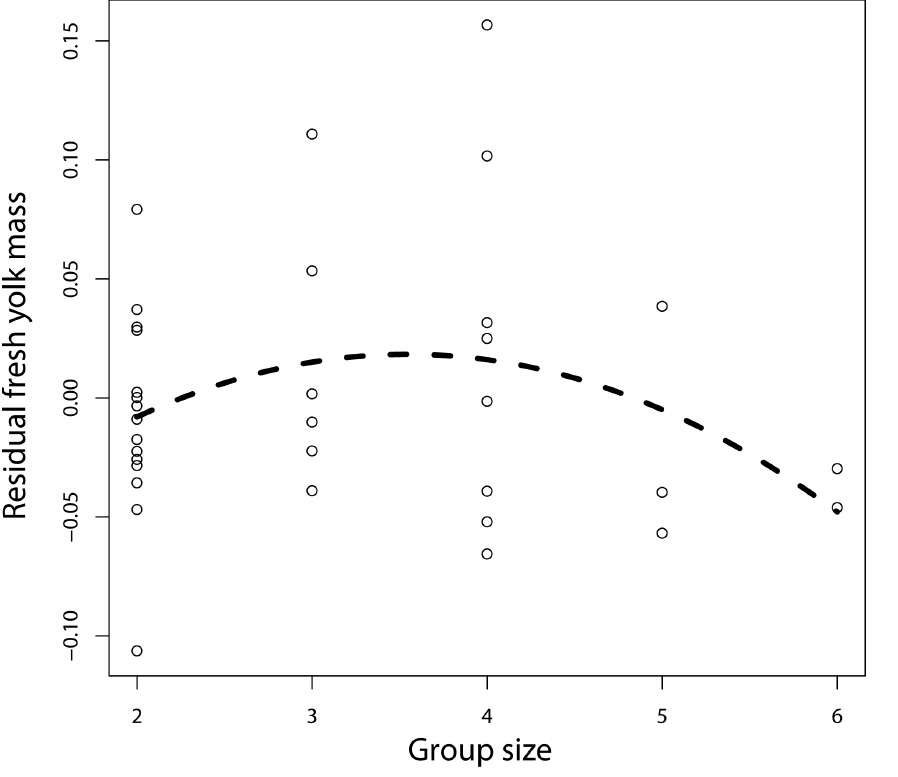
Figure 2. Relationship between fresh yolk mass of first laid eggs (corrected for egg mass) and breeding group size. Dashed line indicates predicted values from the linear mixed-effects model.